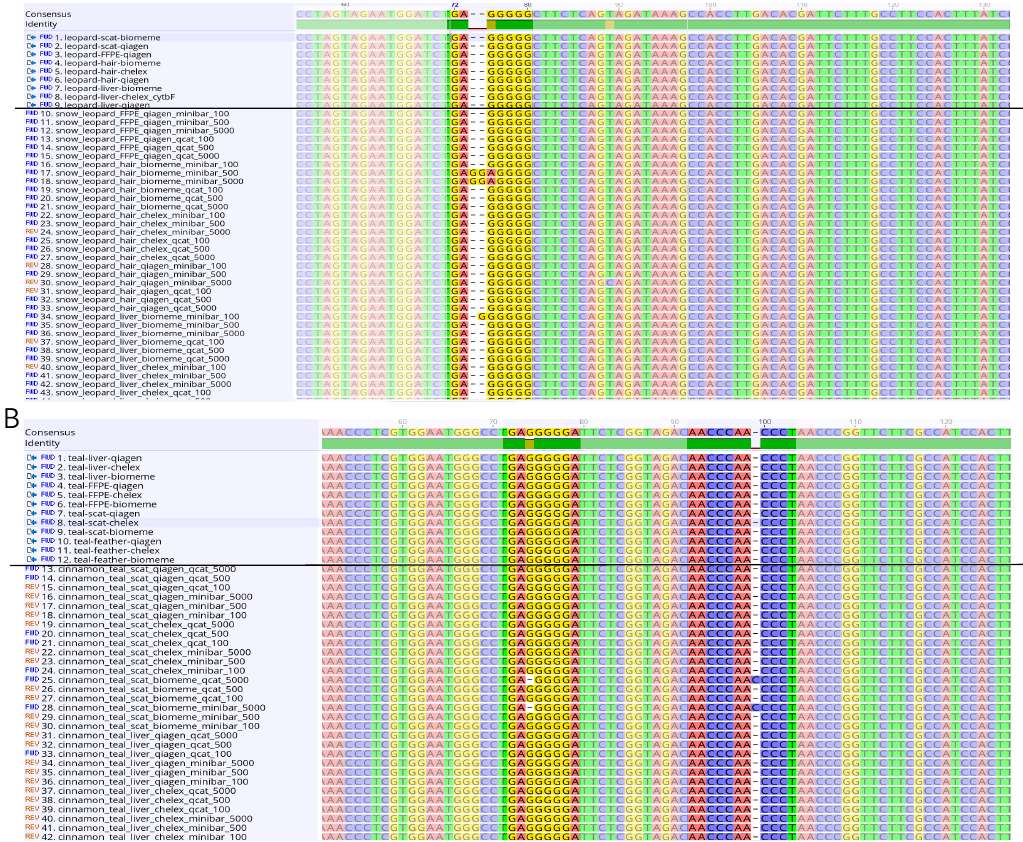
Figure 5. Screenshots of selected sections of the Mafft alignments for ( A ) snow leopard and ( B ) cinnamon teal showing nucleotide sites with differences between sequences in homopolymeric regions. Sanger sequences are listed above the black line and MinION consensus sequences